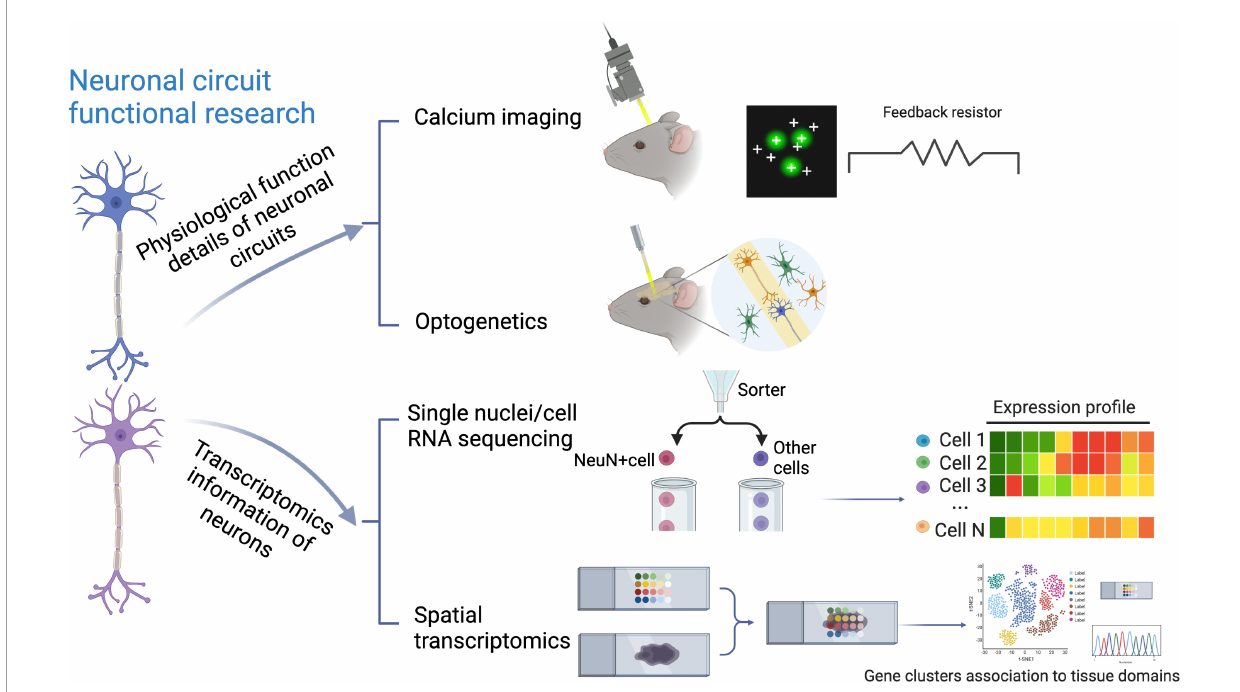
FIGURE1 Traditional and transcriptomic techniques to study neural circuits. Depicted are the traditional techniques including optogenetics and calcium imaging, and recently-applied single-cell transcriptomic approaches, which have been used to investigate neural circuits from different